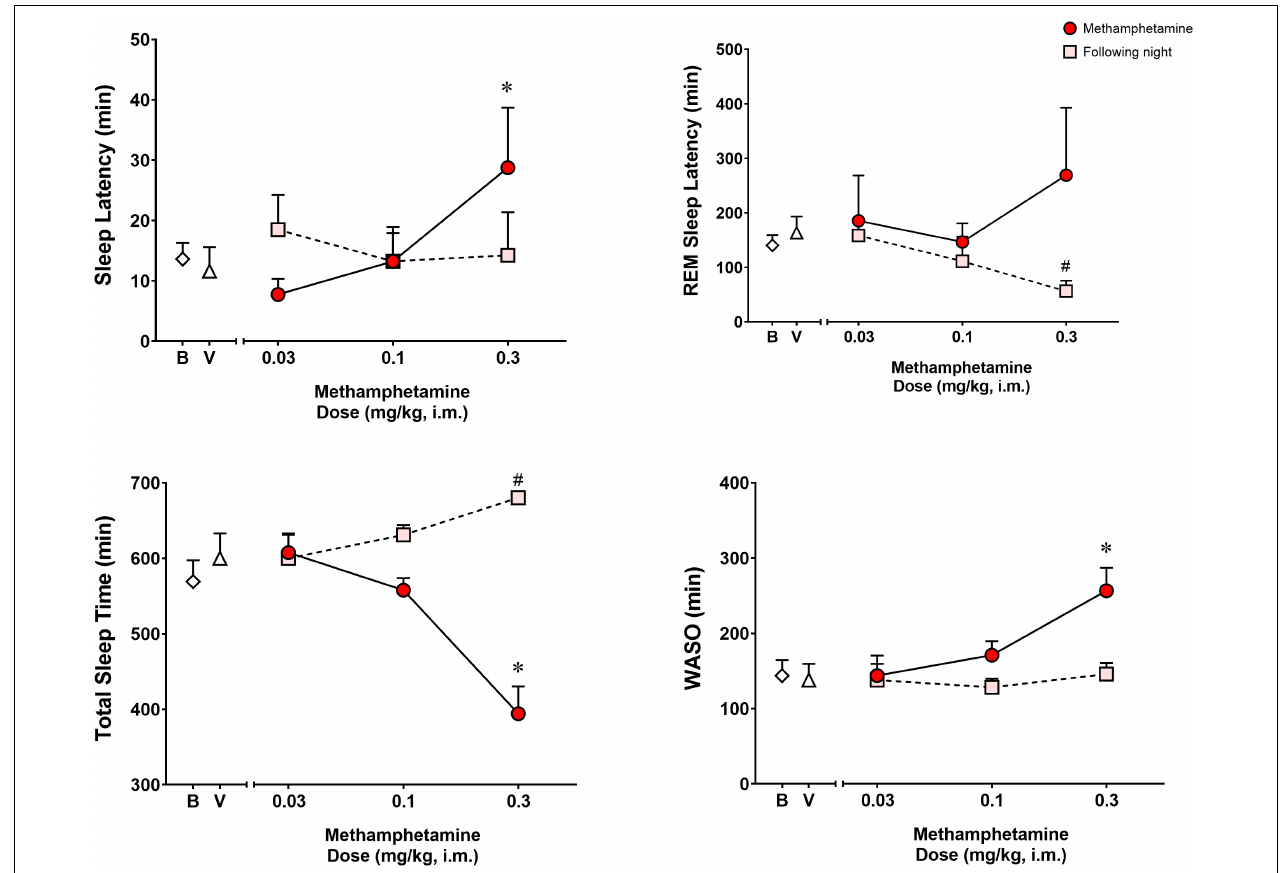
FIGURE 1 | Sleep latency, rapid eye movement (REM) sleep latency, total sleep time and wake time after sleep onset (WASO) on the night of methamphetamine treatments and during the following night (second night after methamphetamine treatments) in male rhesus monkeys ( N = 4). Sleep data on nights